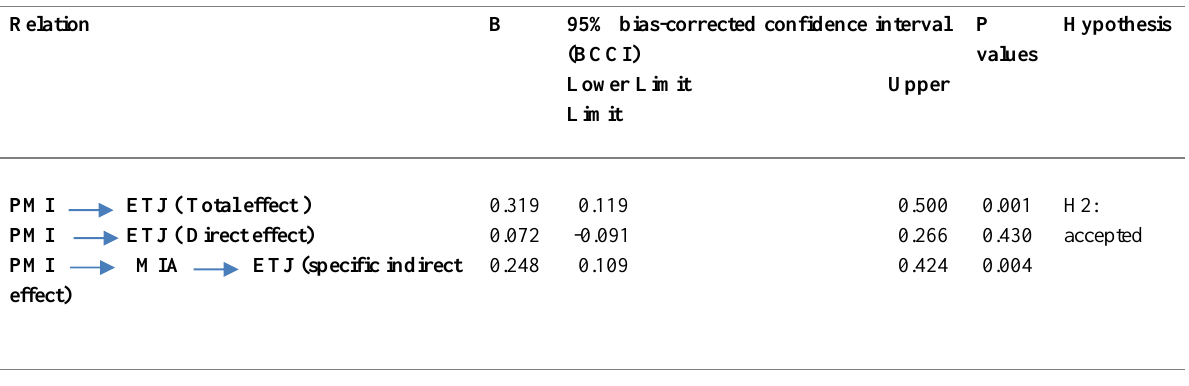
Table 6: Total effects, direct effects, specific indirect